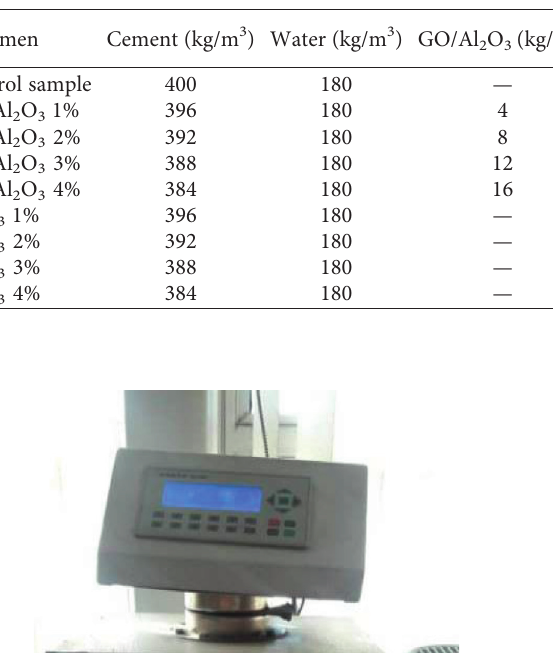
Table 1: Required aggregates for the investigated mix design (kg.m − 3 ).